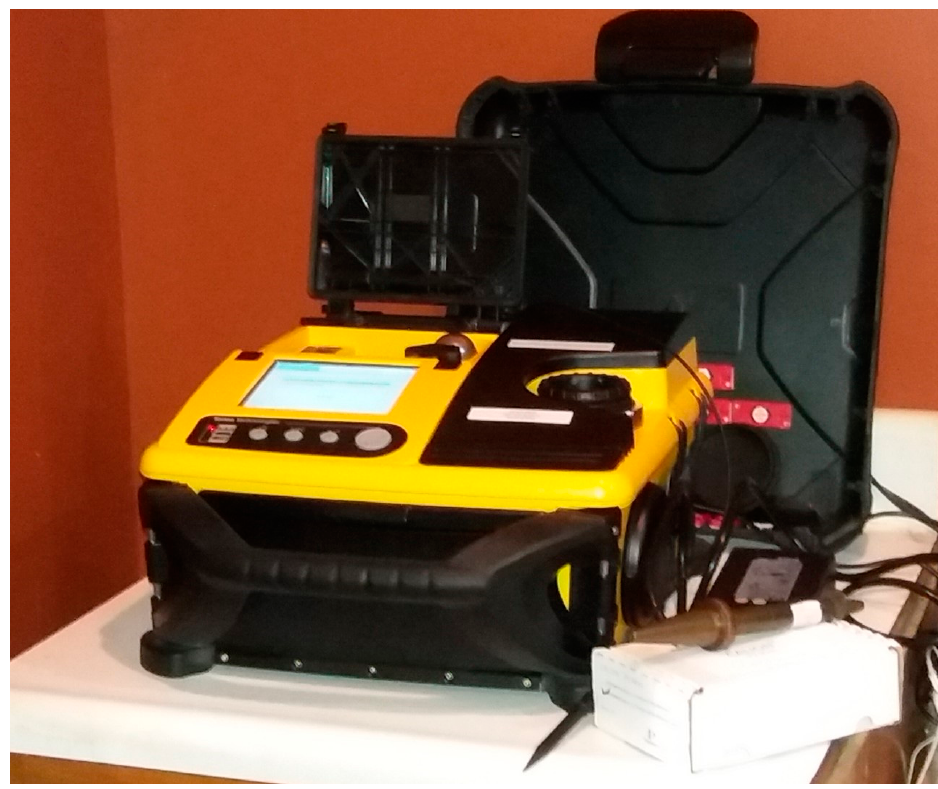
Figure 2. The portable Gas Chromatography Mass Spectrometry (GC/MS) instrument as set up for measurements in the malting house.